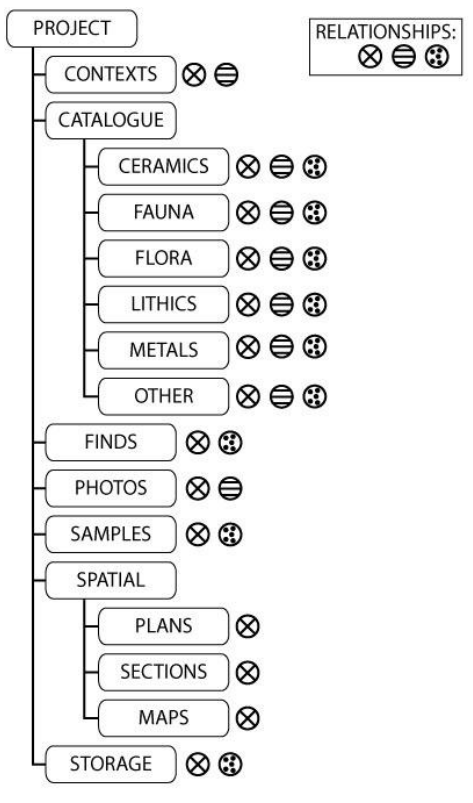
Figure 4: The ArcRange MySQL database